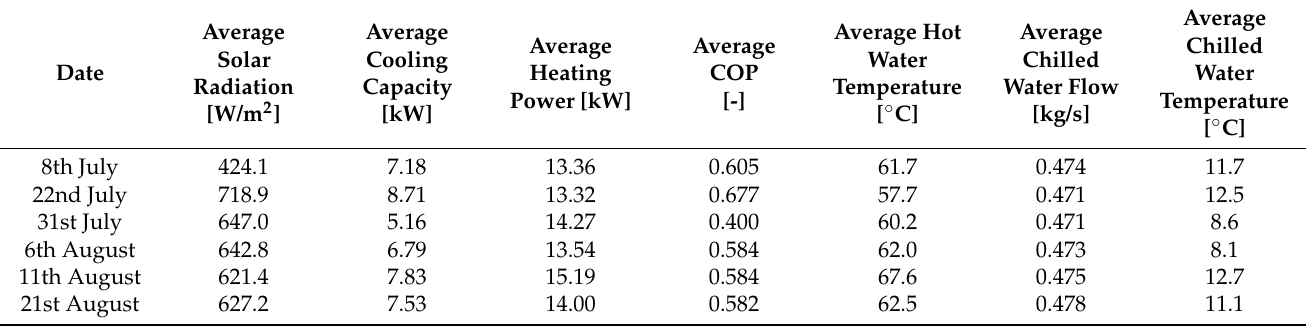
Table 4. Summary of basic system operating parameters for the days